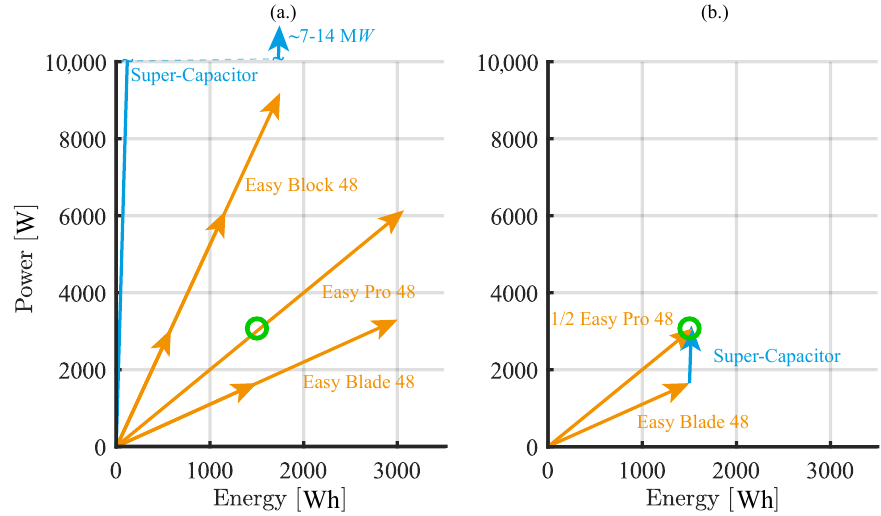
Figure 3. Graphical representation according to Figure 1 of the different possibilities to achieve the system goals with real values: ( a ) With an oversized battery or the super-capacitor module; ( b ) A hybrid solution consisting of the combination of the battery with an optimally designed super-capacitor module. Table 3. Electrical specifications of super-capacitor modules based on SESS.